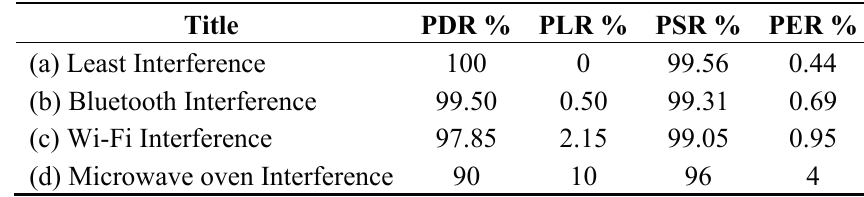
Table 2. Packet reliability parameters affected by different types of ISM band interference